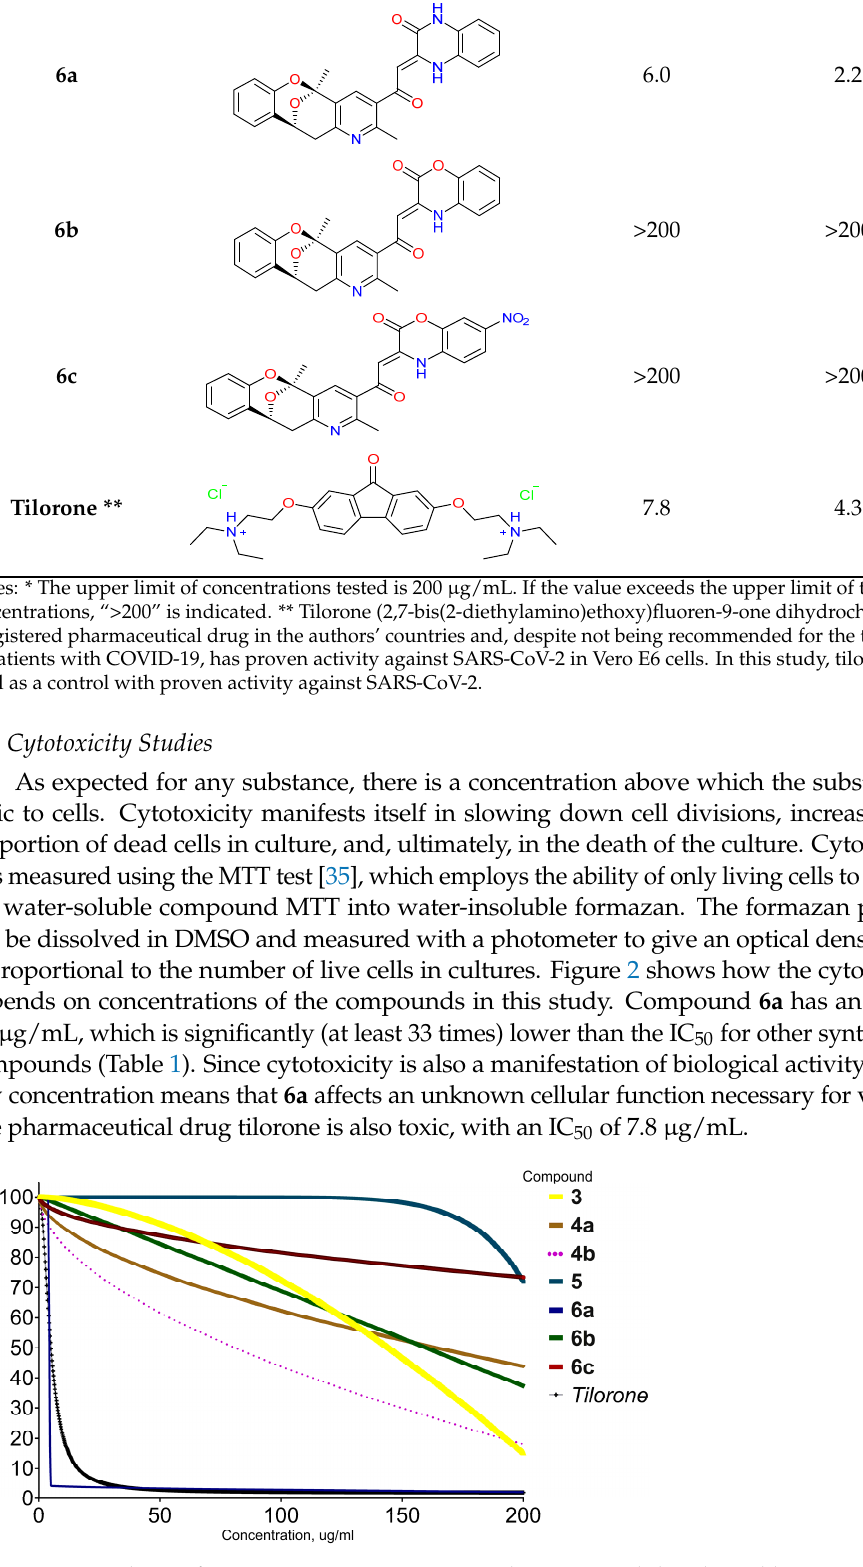
Figure 2. Dependence of cytotoxicity on concentration. The compounds listed in Table 1 were tested to measure cytotoxicity. Tilorone is a pharmaceutical drug known to inhibit the SARS-CoV-2 virus’